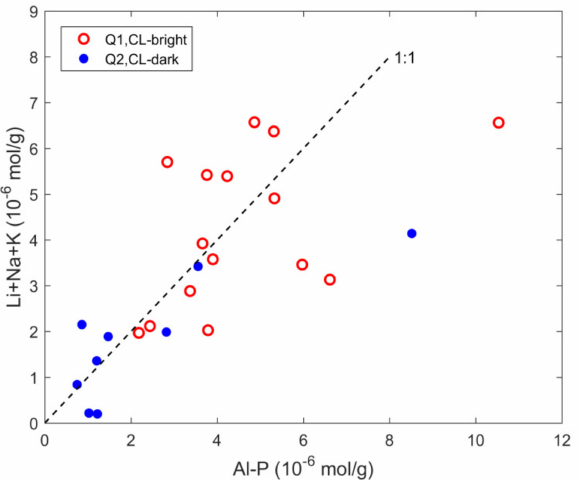
Figure 14. A scatter diagram of Al − P against Li + Na + K concentrations in the two generations of quartz. The dotted line represents the molar ratio (Al − P):(Li + Na + K) =